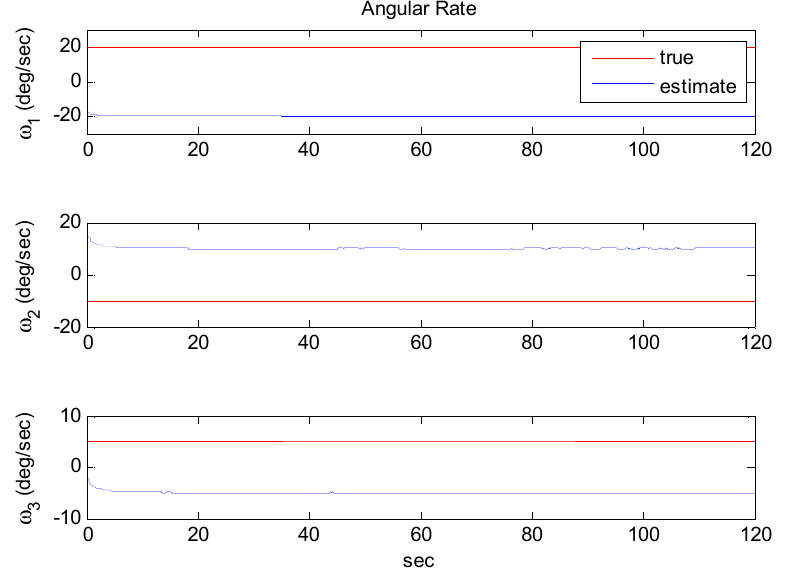
Figure 9. Angular rate estimation with far initial conditions: Case 3-1.